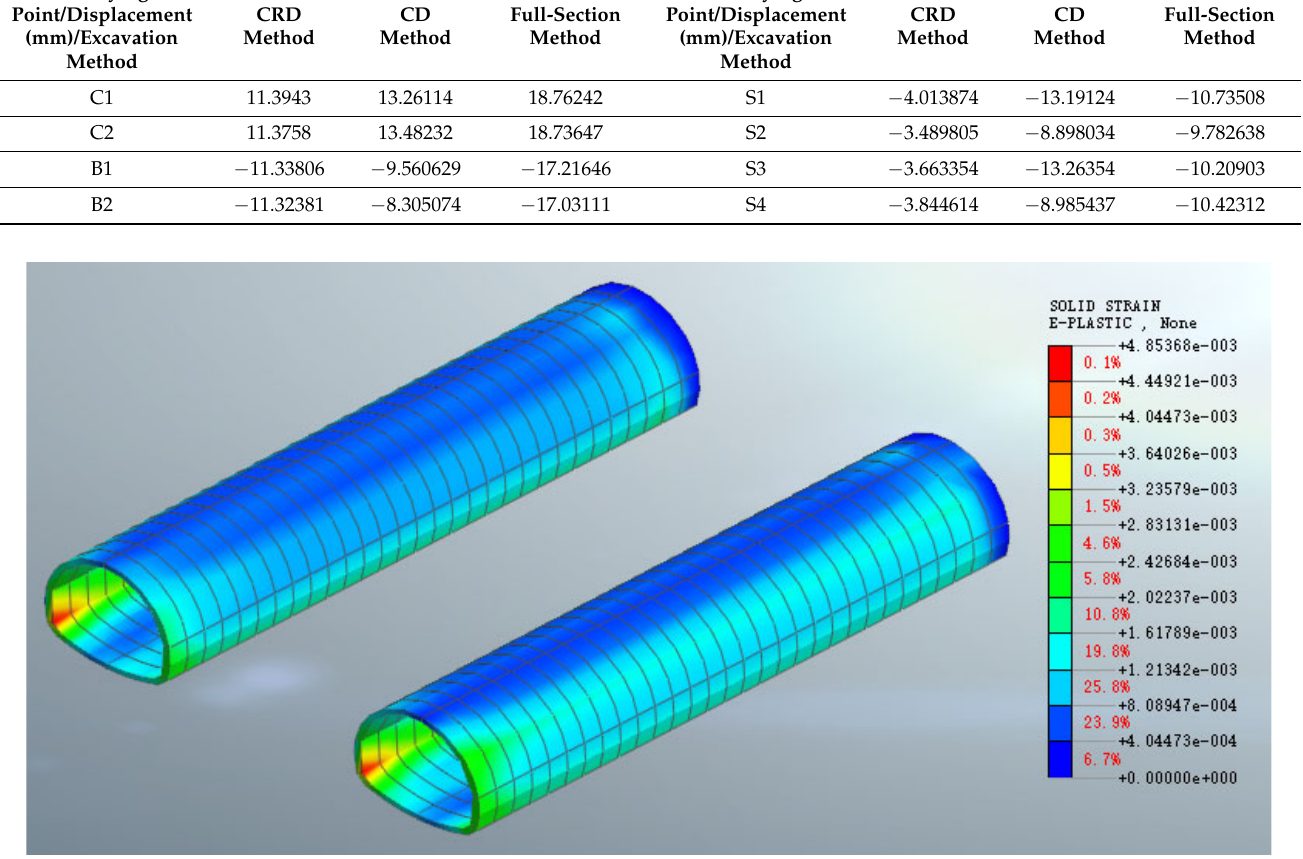
Figure 11. Effective plastic strain of secondary lining by the CRD method. Table 5. Deformation of secondary lining with different excavation methods.